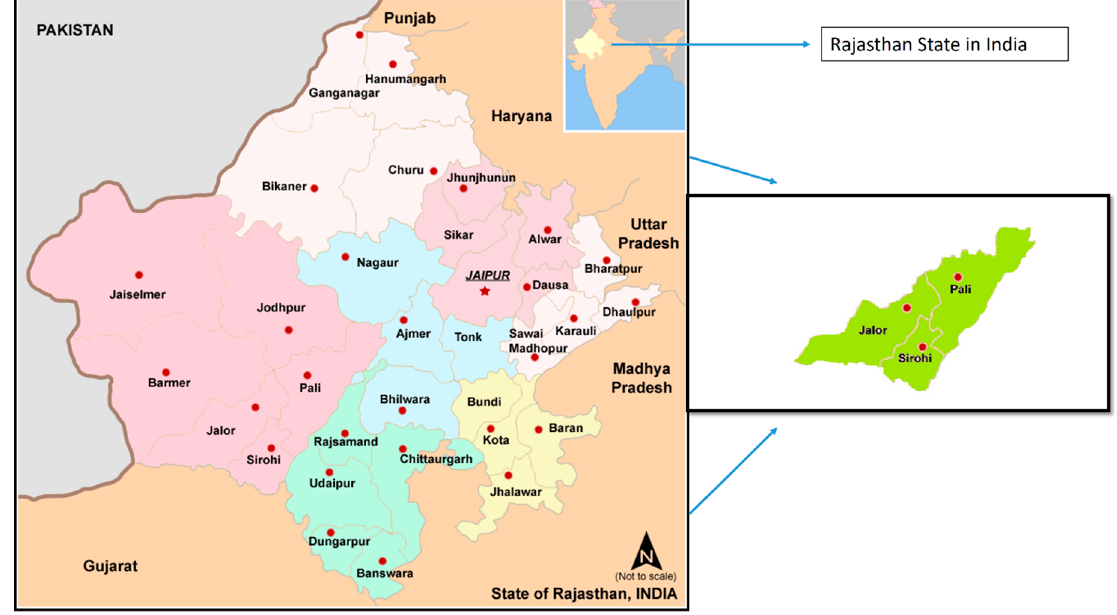
Figure 3. Map of Rajasthan State in India showing Jalore, Pali and Sirohi districts. Source: https://commons.wikimedia.org/wiki/File:Map_rajasthan_dist_7_div.png http://www.mapsofindia.com/maps/rajasthan. Table 1. Divisions and districts of Rajasthan state, India.